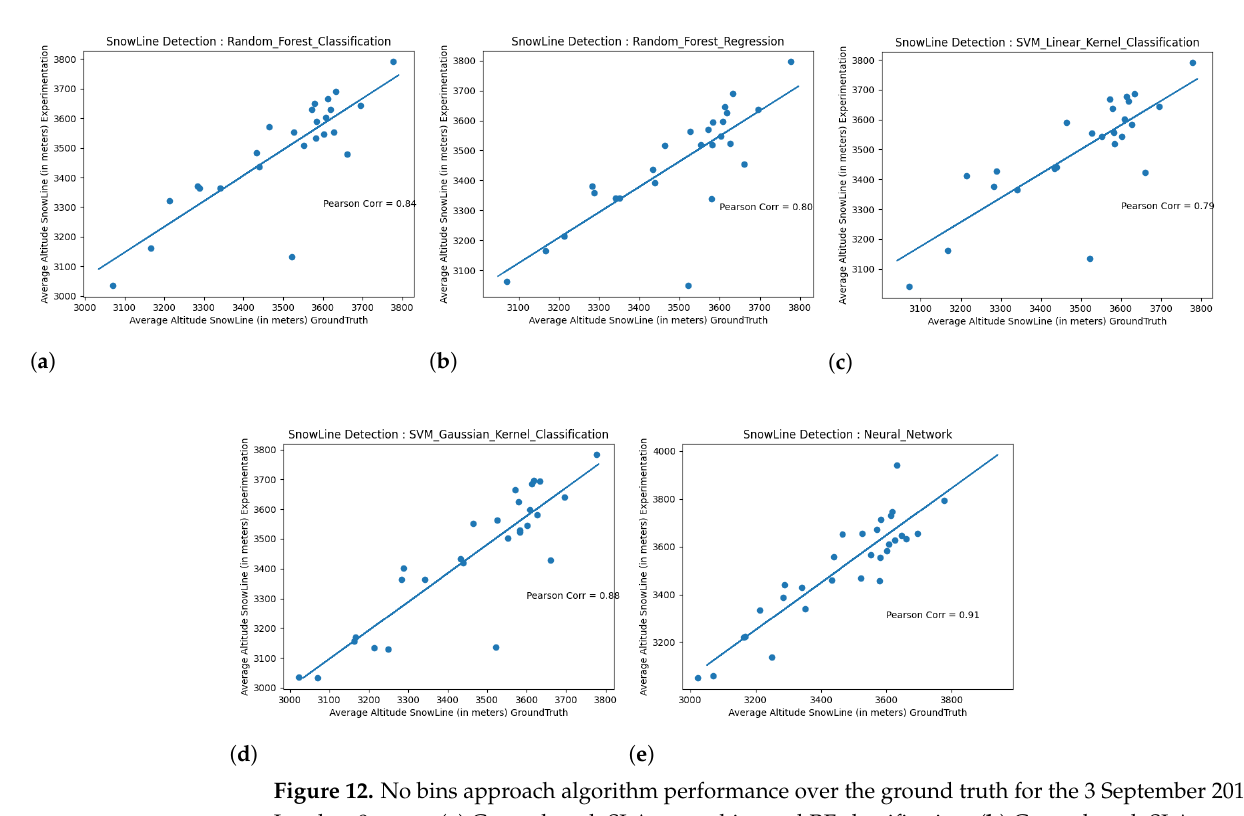
Figure 12. No bins approach algorithm performance over the ground truth for the 3 September 2019 Landsat 8 scene. ( a ) Ground truth SLA vs. no bins and RF classification. ( b ) Ground truth SLA vs. no bins and RF regression. ( c ) Ground truth SLA vs. no bins and SVM and linear kernel classification. ( d ) Ground truth SLA vs. no bins and SVM and Gaussian kernel classification. ( e ) Ground truth SLA vs. no bins and SVM and neural network classification.